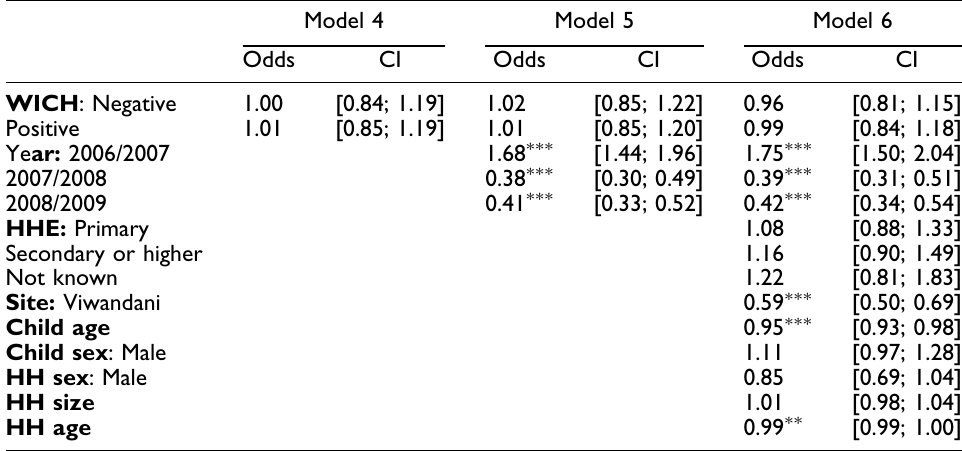
Table 4. Odds ratio from logistic regression models on shift to private informal school only (n = 15597; clusters = 6965).